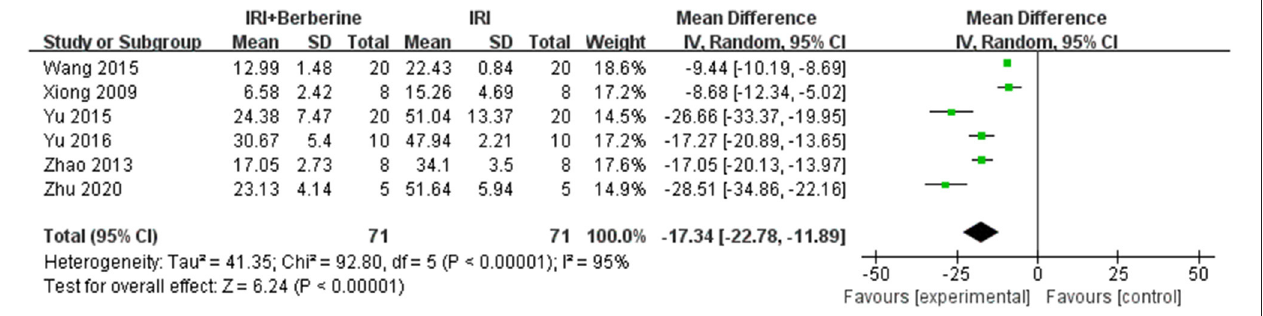
FIGURE 10 | Forest plot showing effects of BBR on decreasing the index of myocardial apoptosis compared with the control group.